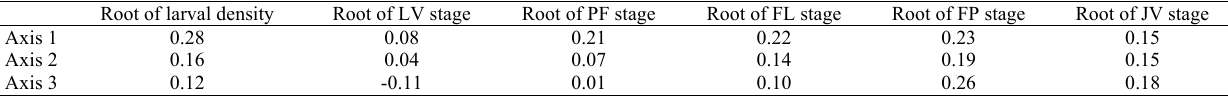
Table 2. Pearson correlation coefficient between the square root of the density of Rhamdia quelen larvae by developmental stage and the scores of PCA axes in Ilha Grande National Park. Values in bold indicate significant correlations (p<0.05).